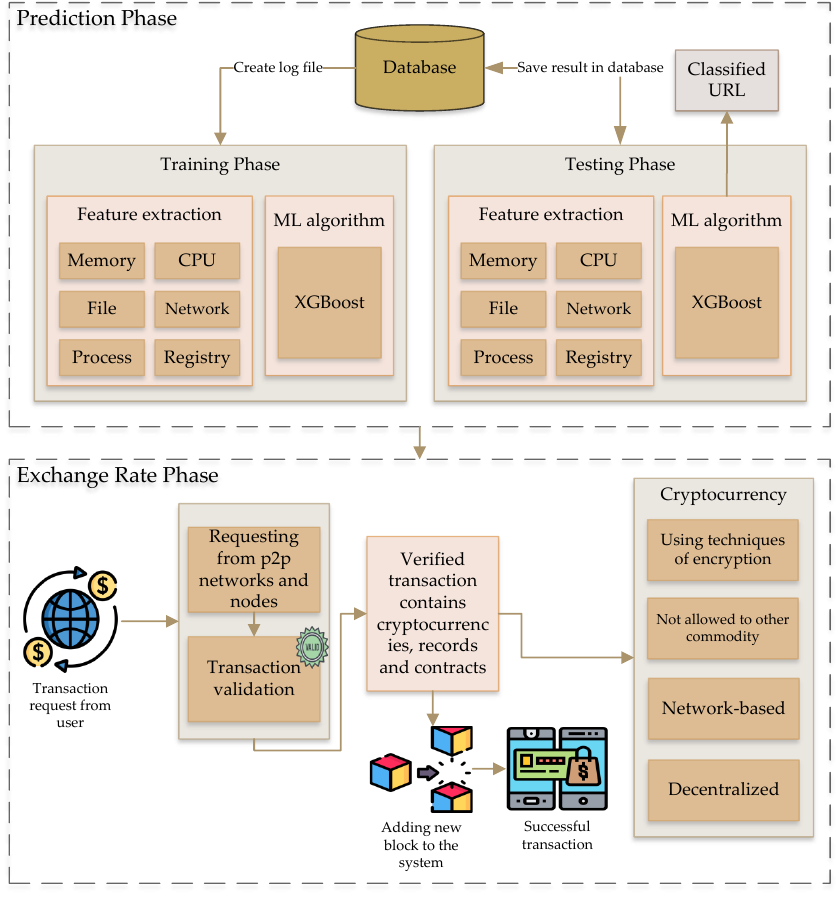
Figure 2. Overview of exchange rate prediction of the proposed